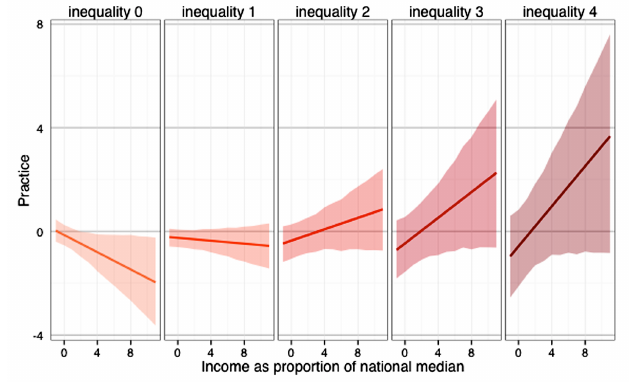
Fig. 6 . Income drives participation in practice roles, and the strength and direction of the effect is determined by national- level inequality. Plot shows model predictions (with unplotted variables held at constant values) and 95% Highest Posterior Density bands. Rug plots along each axis show the distribution of individual